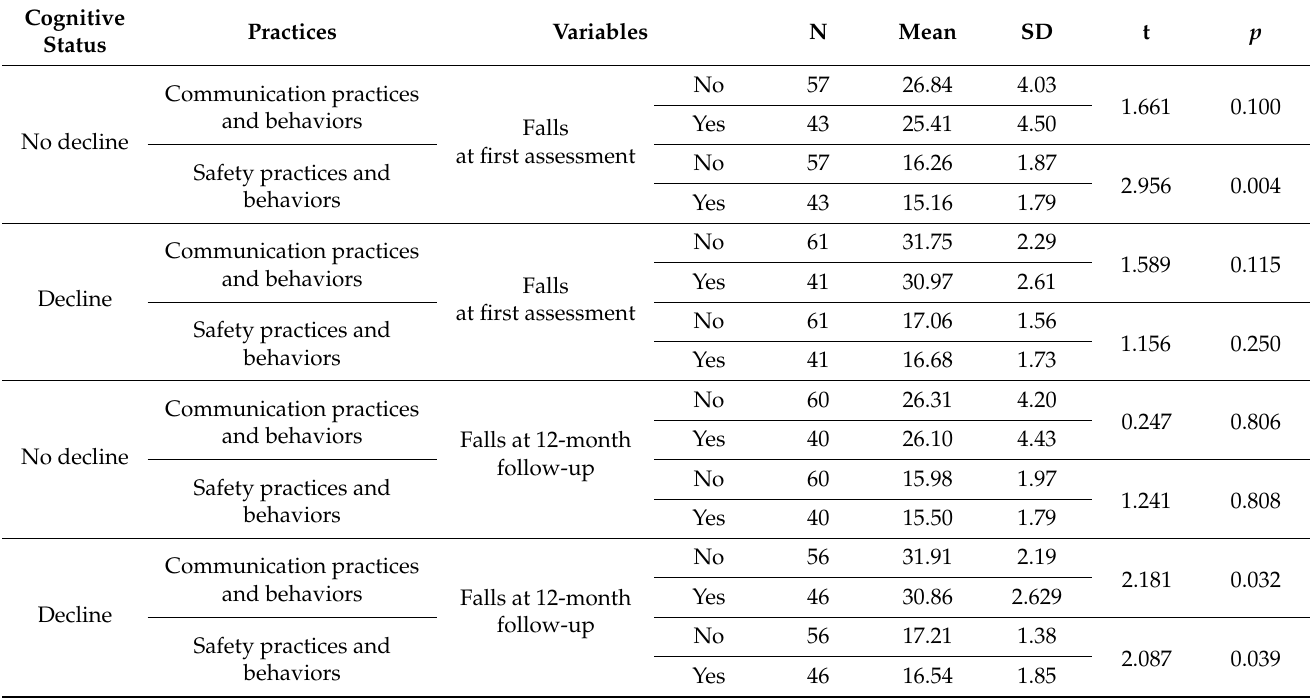
Table 2. Results of Student’s t -test relative to the practices and behaviors of older adults to manage risk of falls according to older adults who had fallen at the first assessment and at 12-month follow-up by cognitive status. Lisbon; 2020.